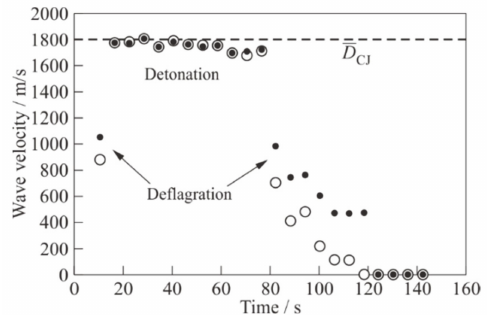
Figure 7. The measured values of SW velocity (dark circles) and flame front velocity (light circles) in each PDT shot in the experiment of Figure 6 ( T p = 765 ◦ C and m 0 = 10 g). The horizontal dashed line corresponds to the typical value of the CJ detonation velocity, D CJ , in stoichiometric fuel mixtures of hydrocarbon fuels.